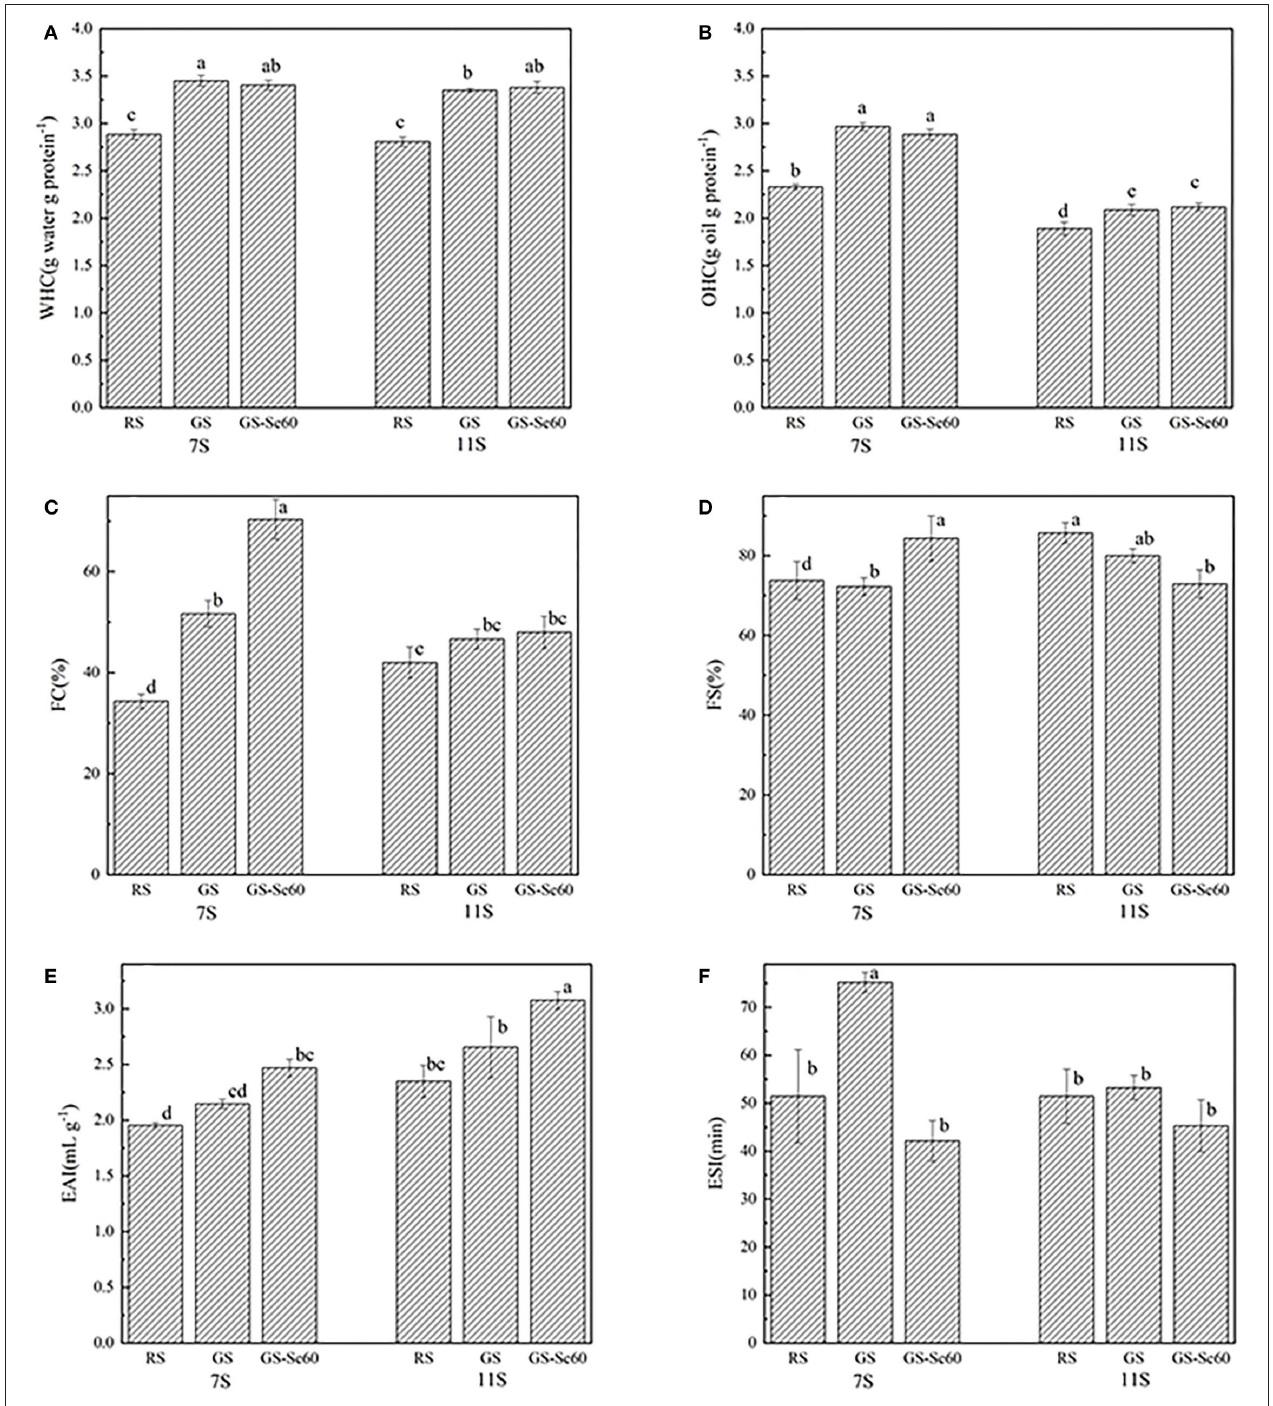
FIGURE 4 | Functional properties of different soybean proteins treated with or without Se. (A) Water holding capacity (WHC), (B) oil holding capacity (OHC), (C) foaming capacity (FC), (D) foam stability (FS), (E) emulsion activity index (EAI), and (F) emulsifying stability index (ESI). Different letters are used to show significant differences at various treatments ( p <